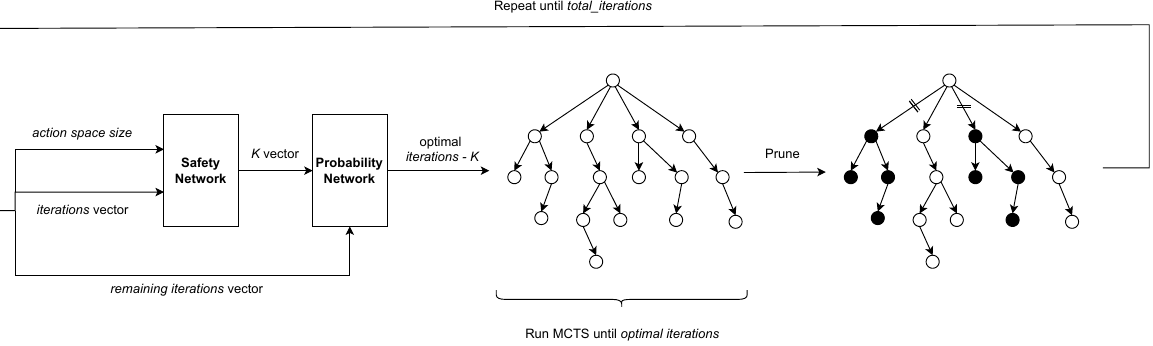
Figure 1. Proposed pruning process for MCTS (pruned nodes are marked as